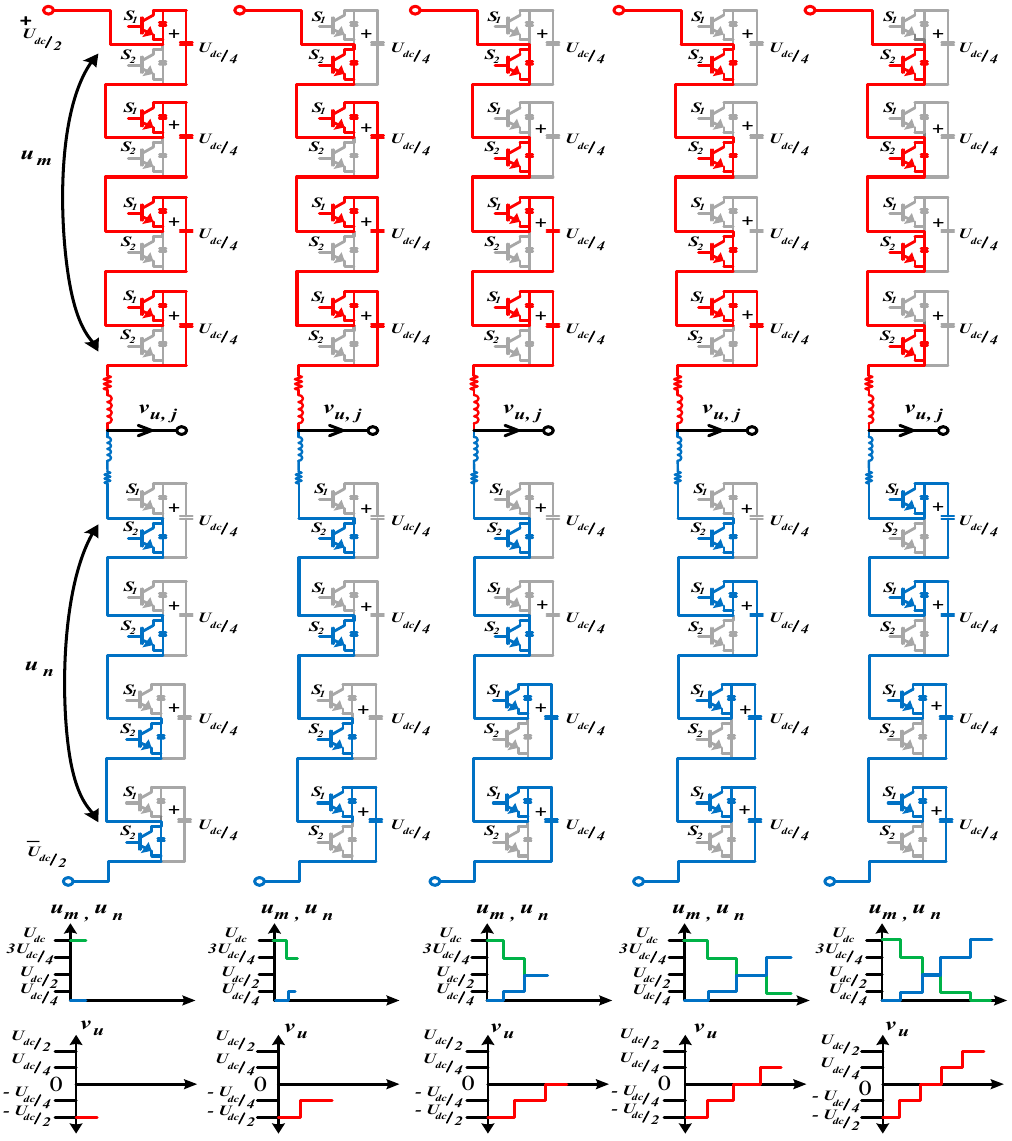
Figure 2. Switching operation of the single phase MMC. Table 1. Capacitor states.